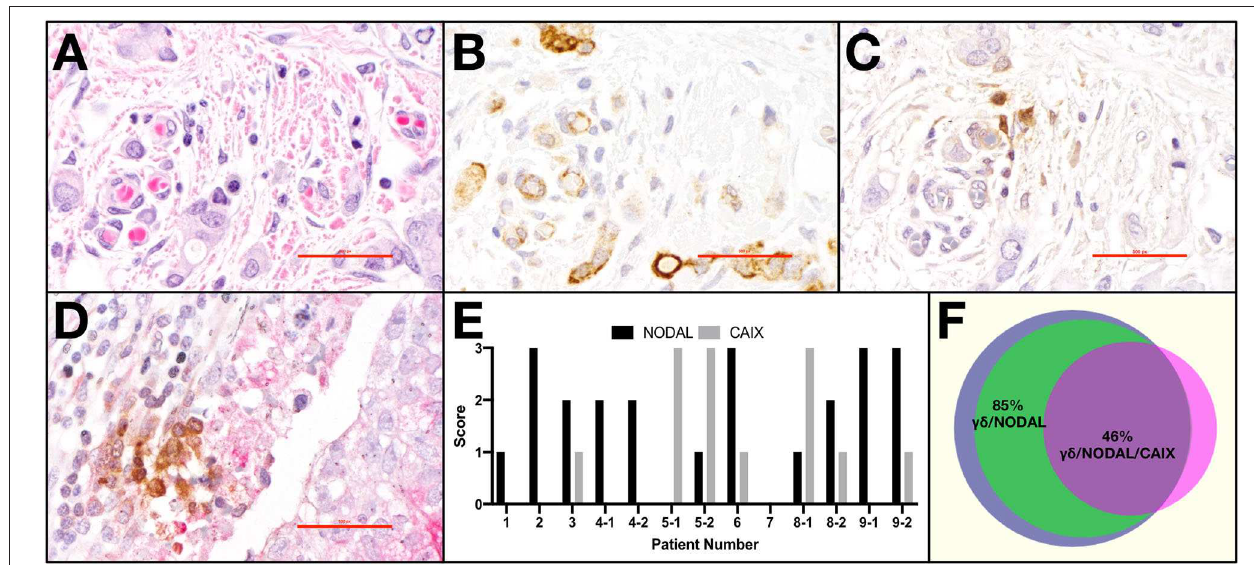
FIGURE 1 | γδ T cells and NODAL are co-localized in breast tumor tissues from patients. Representative example of paraffin-embedded serial sections from a triple negative breast tumor stained via immunohistochemistry for (A) H&E with hematoxylin staining nuclei dark blue-purple and eosin indicating cytoplasm in pink, (B) NODAL indicated by brown DAB staining, (C) TCR δ also stained brown with DAB, (D) Representative example of TCR δ (brown) found in a CAIX-positive region, stained pink with permanent red dye; scale bar = 40 µ m. (E) Scoring for NODAL and CAIX expression in tumor sections in which γδ T cells were identified. Cases in which more than one slide was positive for TCR δ are indicated with − 1, − 2 designations. (F) Venn diagram depicting co-localization of γδ T cells (blue), NODAL (green), and CAIX (fuchsia). Percent overlaps are